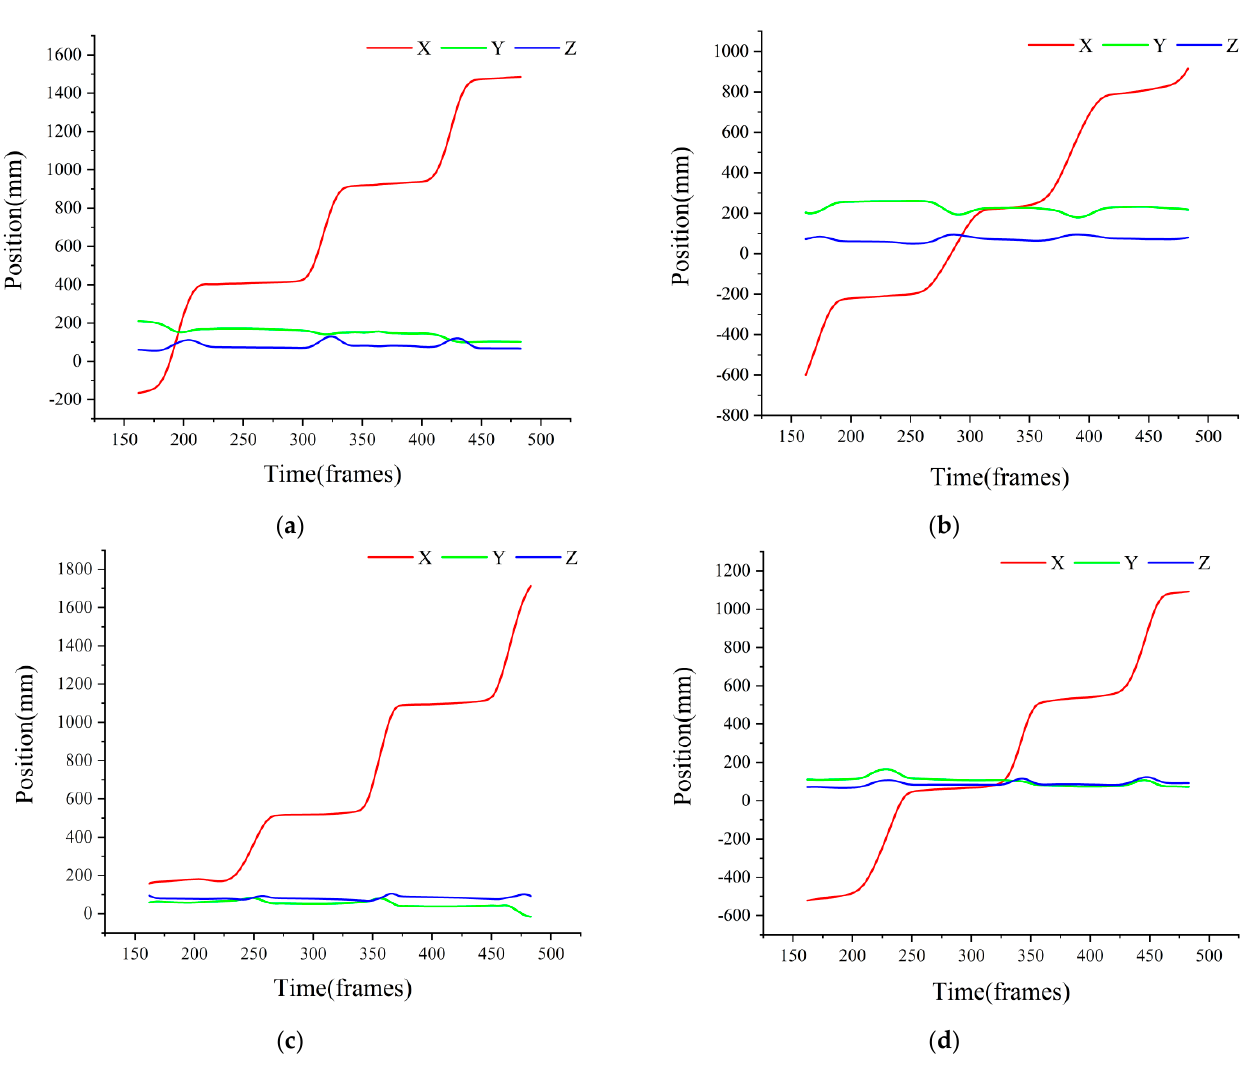
Figure 4. The trajectory of the third marker of the limbs along the X-, Y-, and Z-directions under the slope of 0°: ( a ) the trajectory of the third marker of the left front leg; ( b ) the trajectory of the third marker of the left hind leg; ( c ) the trajectory of the third marker of the right front leg; ( d ) the trajectory of the third marker of the right hind leg.